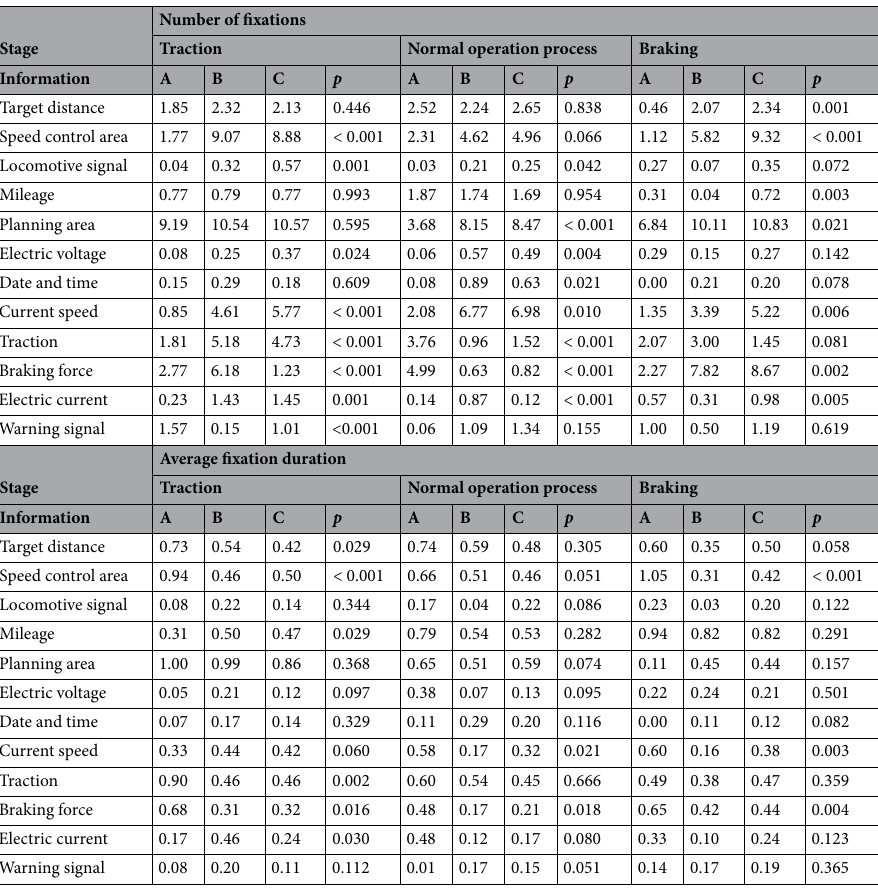
Table 3. Number of fixations and average fixation duration of the three groups on the interface